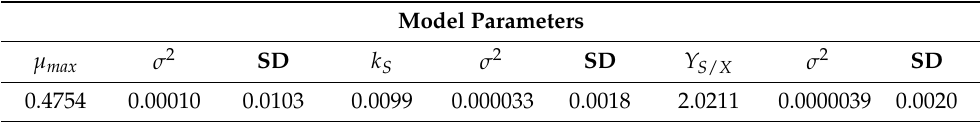
Table 6. Obtained model parameter estimations of ABC-GA hybrid algorithm.